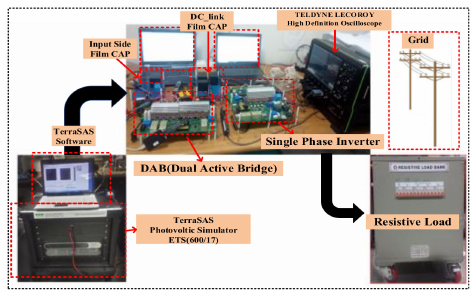
Figure 11. Experimental setup of a 5 kW two-stage DC / AC converter.